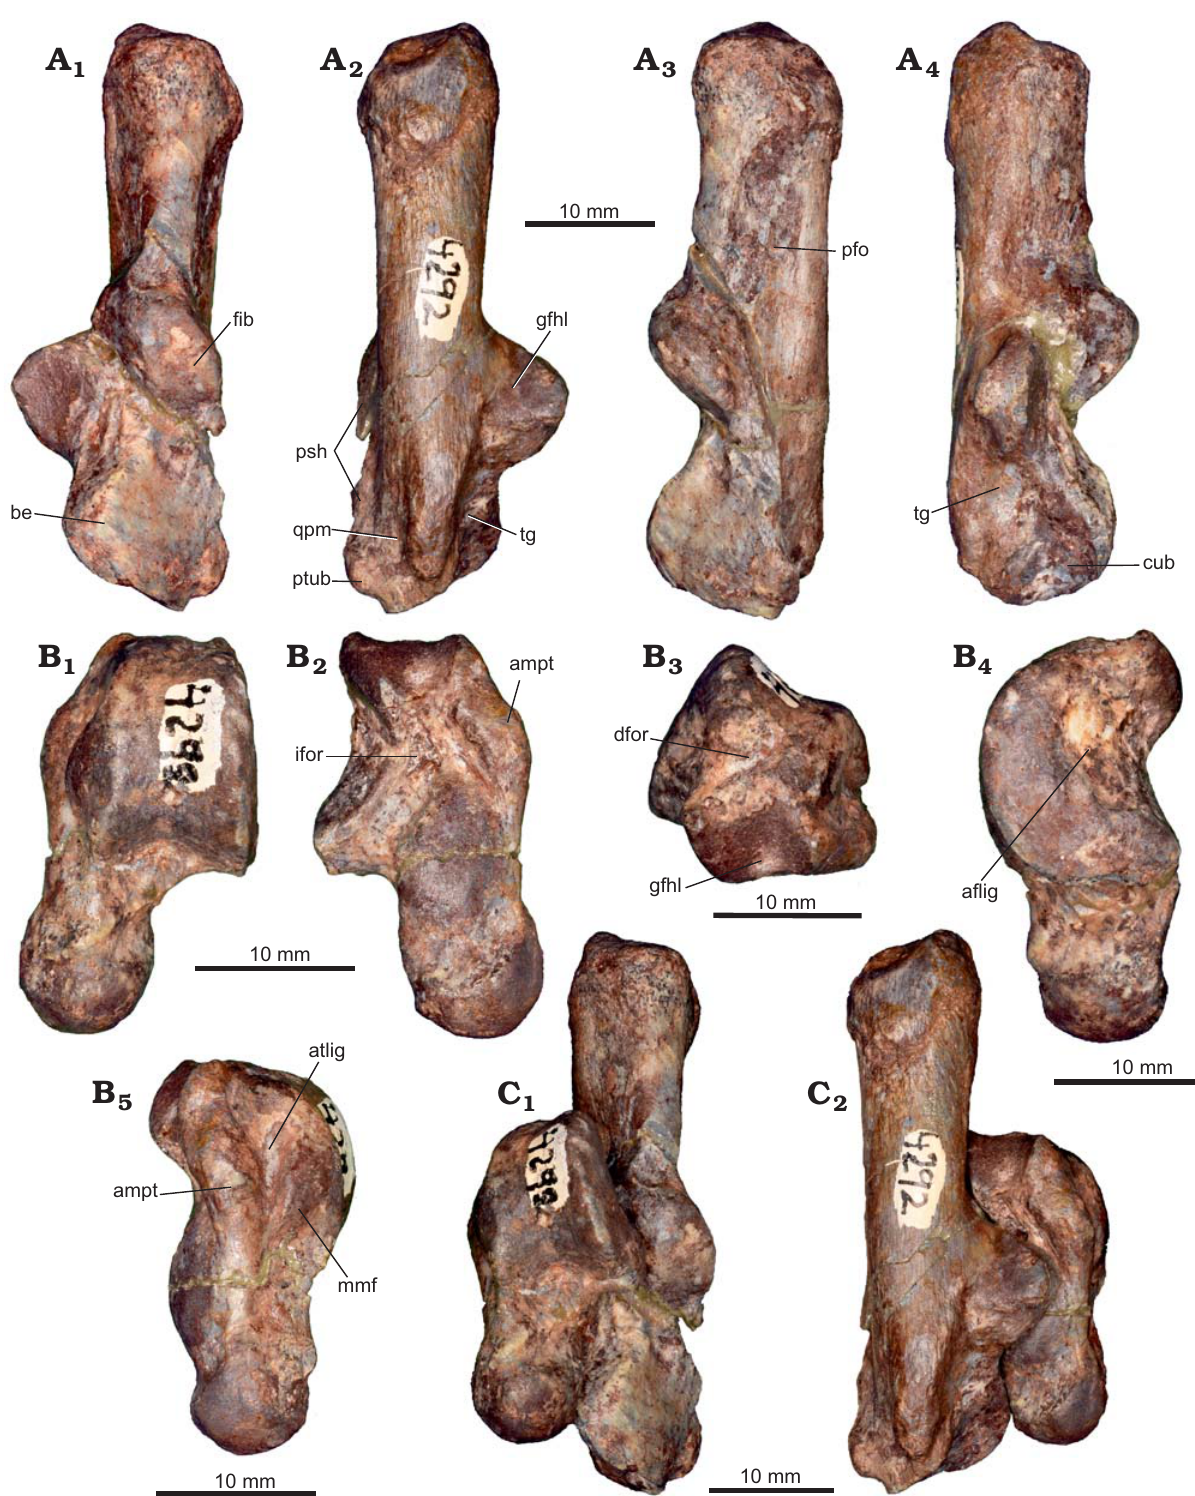
Fig. 4. Tarsal bones of Typotheria indet. (PVL 4292) from Pampa Grande, Salta Province, Argentina, Lower Lumbrera Formation, middle Eocene (Vacan subage of the Casamayoran SALMA). A . Left calcaneum in dorsal (A 1 ), plantar (A 2 ), lateral (A 3 ), and medial (A 4 ) views. B . Left astragalus in dorsal (B 1 ), plantar (B 2 ), posterior (B 3 ), lateral (B 4 ), and medial (B 5 ) views. C . Articulated proximal tarsals in dorsal (C 1 ) and plantar (C 2 ) views. Abbreviations: aflig, attachment for the fibuloastragalar ligament; ampt, astragalar medial plantar tuberosity; atlig, attachment for the tibioastragalar ligament; be, “beak” (Cifelli 1983, 1993); cub, cuboidal facet; dfor, dorsal astragalar foramen; fib, fibular facet; gfhl, groove for the tendon of the flexor hallucis longus muscle; ifor, inferior astragalar foramen; mmt, facet for the medial malleolus of the tibia; pfo, peroneal fossa; psh, peroneal shelf; ptub, peroneal tubercle; qpm, attachment of the quadratus plantae muscle (Cifelli 1983); tg, tendinous